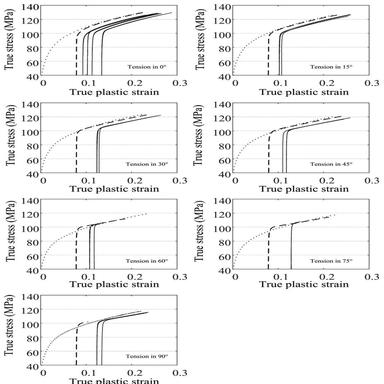
True stress-strain curves in uniaxial tension along every 15° from the RD. Dotted lines represent the monotonic true stress-strain curve in the same direction as the reloading. Dashed lines represent tension tests with 8% pre-deformation in tension along the RD, while solid lines represent tension tests with a further pre-deformation step by rolling in the TD. All curves are plotted up to necking.